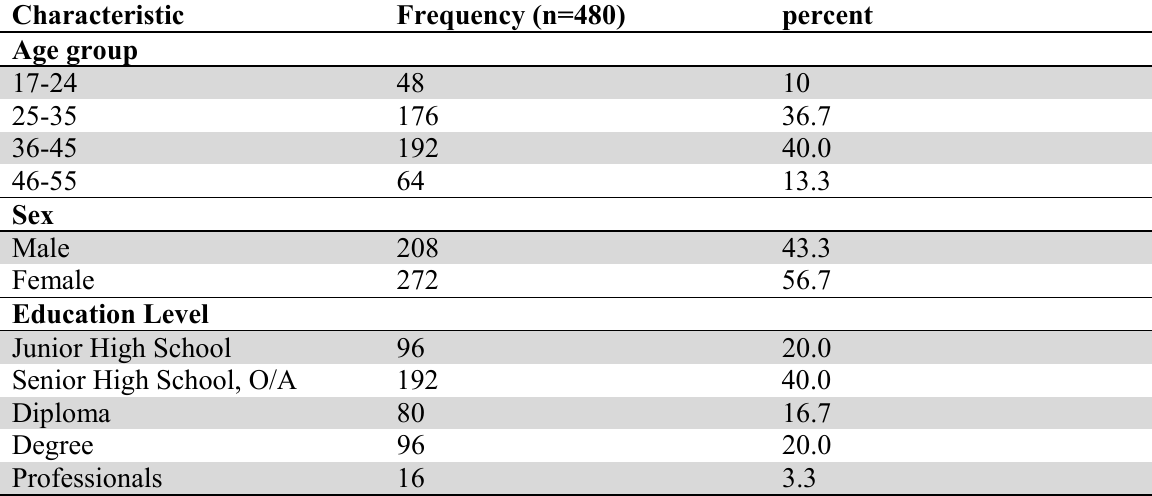
Demographic Characteristics of Study